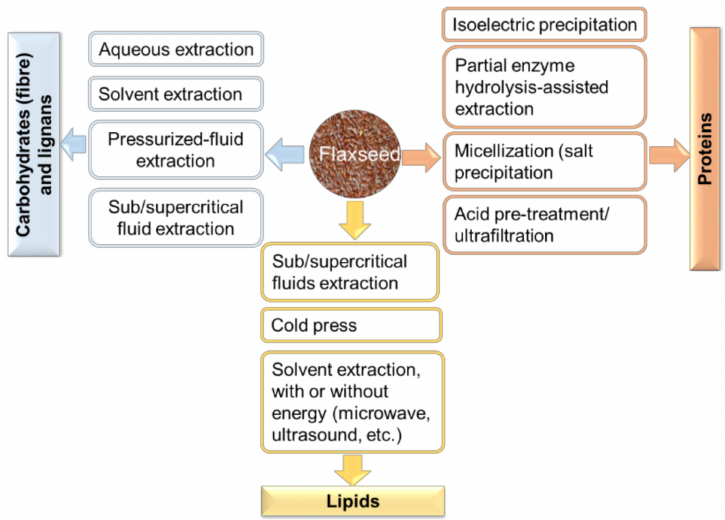
Figure 4. Processes for the biorefinery of flaxseed to obtained functional